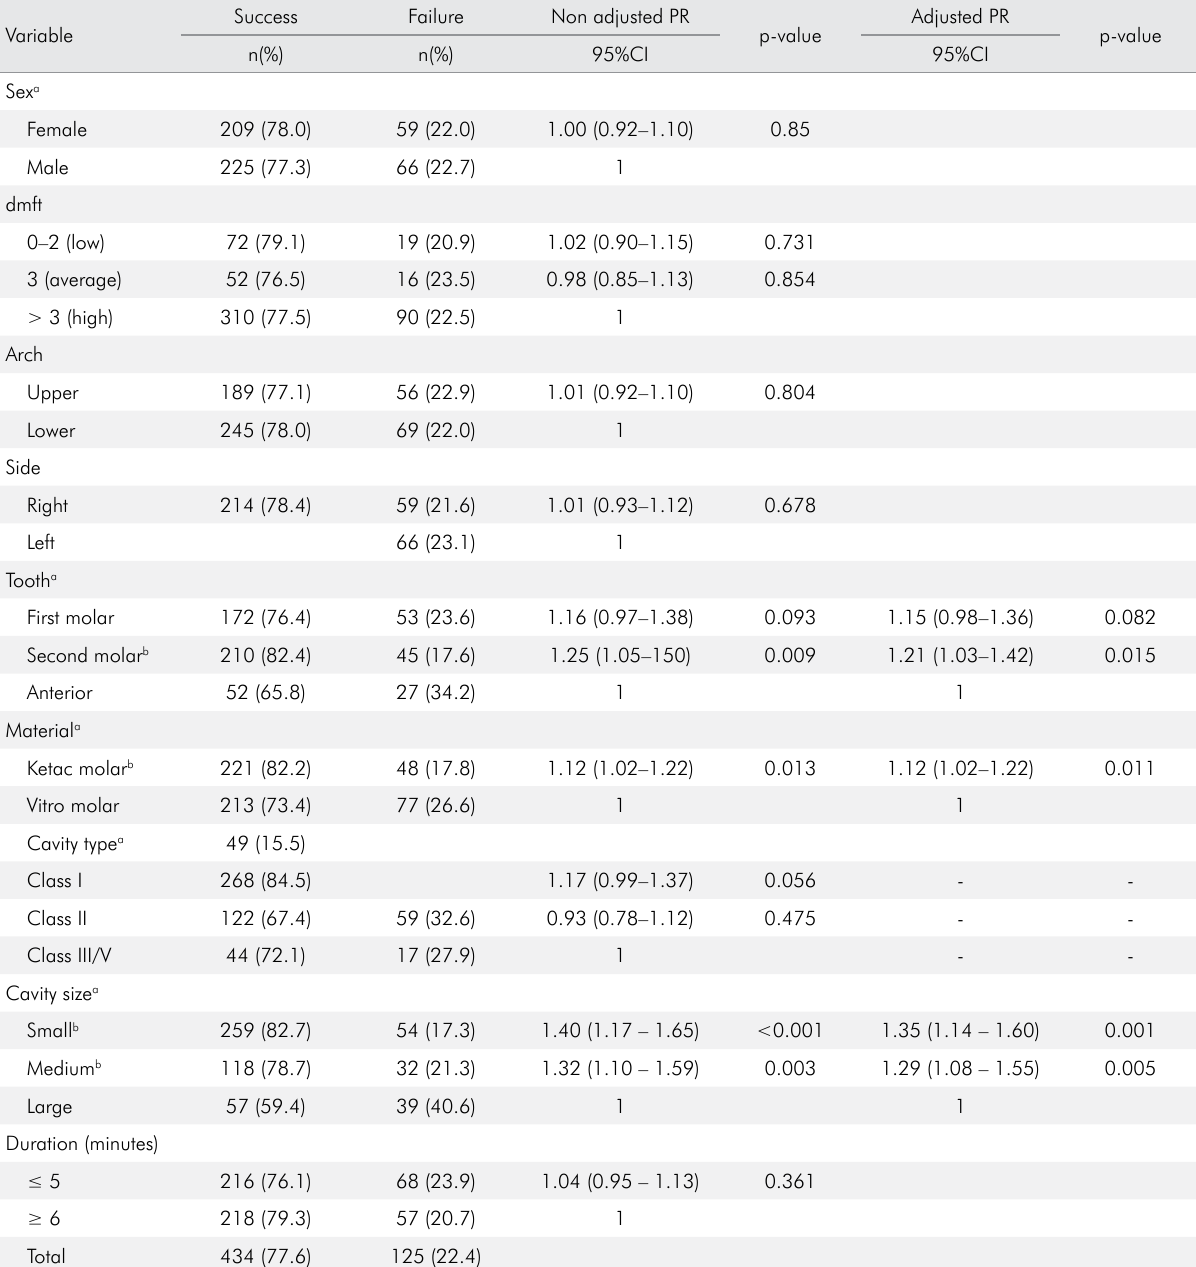
Table 3. Factors associated with the survival of restorations after twelve